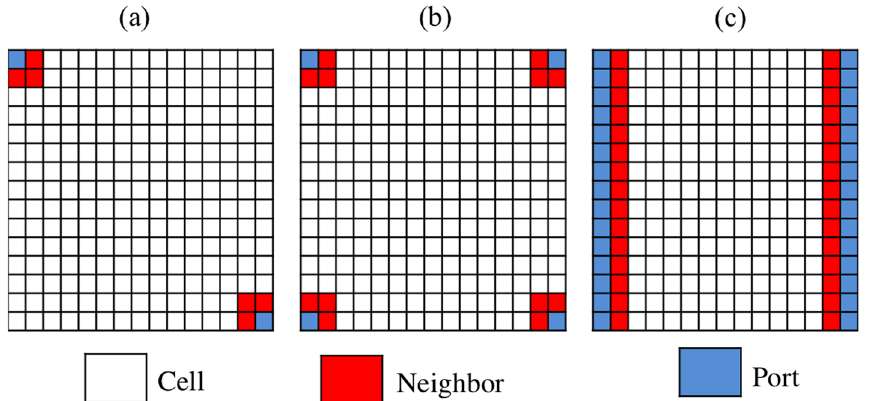
Fig. 3 Port configurations. Subfigure a is the basic two ports; subfigure b is the corner configuration; and subfigure c is the lateral